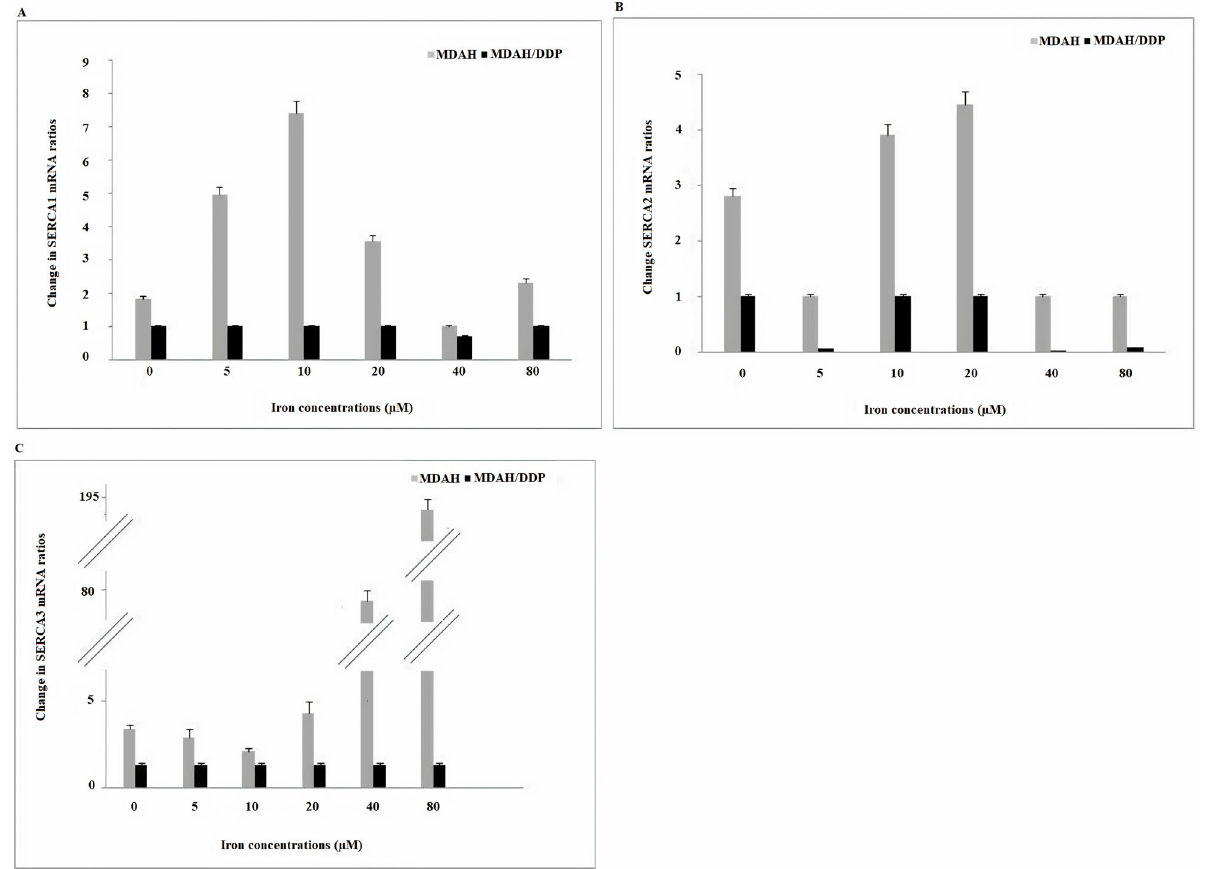
Figure 3. Gene expression of SERCA1/2 and SERCA3 Ca 2+ pumps in the ER at increasing iron concentrations in MDAH and MDAH/DDP cells. The levels of change in mRNA expression rates for each sample were determined with respect to actin by RT-PCR method. A: SERCA1 ; B: SERCA2 ; C: